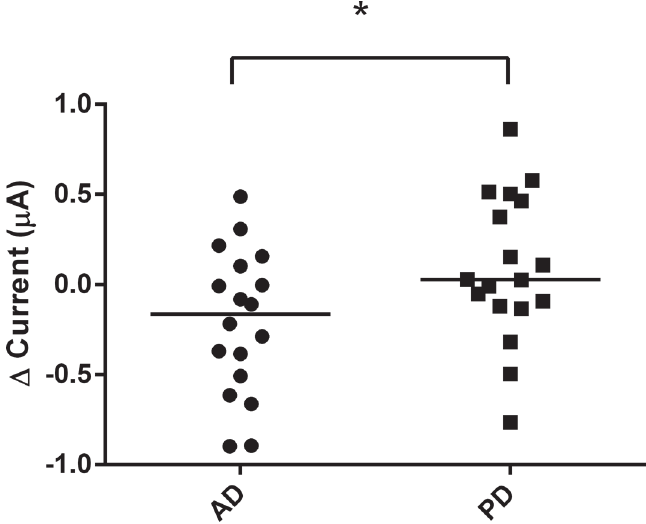
Fig 7. Change in EG-ISFET biosensor current for AD and PD saliva samples. The change of current generated from the AD and PD groups after the values were normalized to the values obtained from the control group of healthy individuals. Values are represented as median (left). * p (cid:1) 0.05.